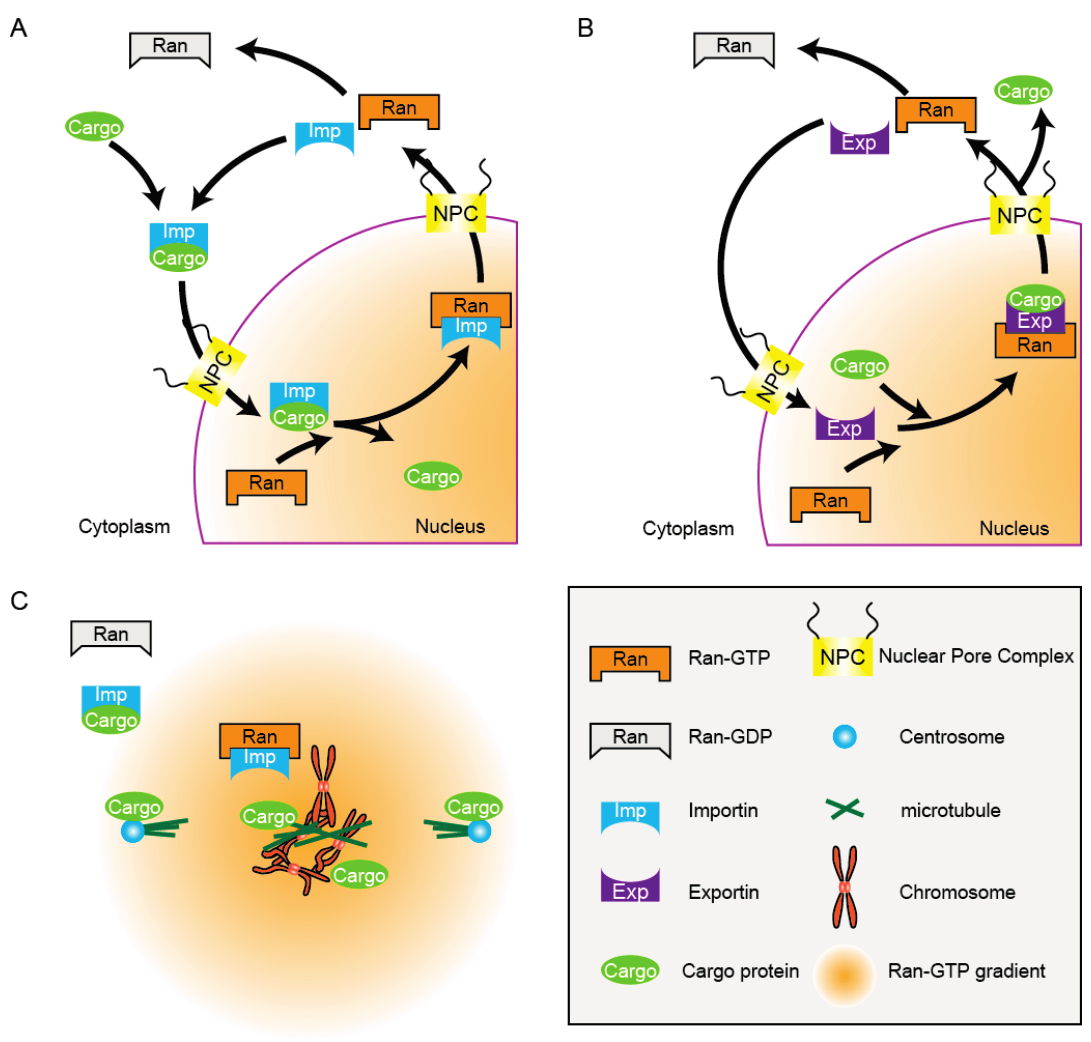
Figure 1. The nuclear transport cycle and spindle microtubule assembly governed by Ran-GTP. ( A ) A schematic of the nuclear import cycle. The importin-cargo complex assembles in the presence of Ran-GDP in the cytoplasm and its interaction with Ran-GTP unloads the cargo in the nucleus. ( B ) A schematic of the nuclear export cycle. Exportin and a cargo associate in the nucleus in the presence of Ran-GTP but dissociate in the cytoplasm. ( C ) In mitosis, the nuclear envelope breaks down (NEBD) and spindle microtubules are assembled in the close vicinity of chromosomes. Ran-GTP molecular gradient centered around the chromosomes dissociates the target molecules (cargos) through an interaction with